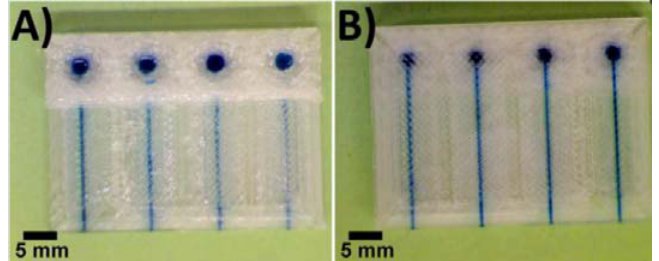
Figure 9. Top view ( A ) and bottom view ( B ) of semi ‐ transparent 3D ‐ printed 800 μ m × 800 μ m square cross ‐ sectional PET channels filled with 1 mM methylene blue solution. (Reproduced with permission from [33].)